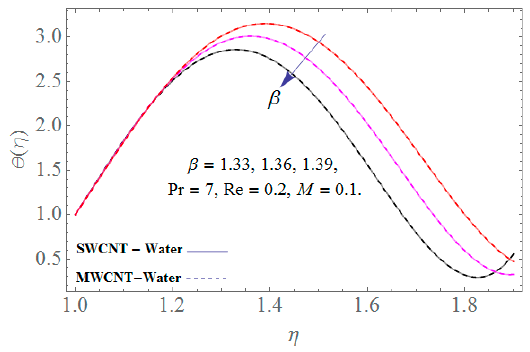
Figure 8. Impact of the Prandtl number versus temperature field.